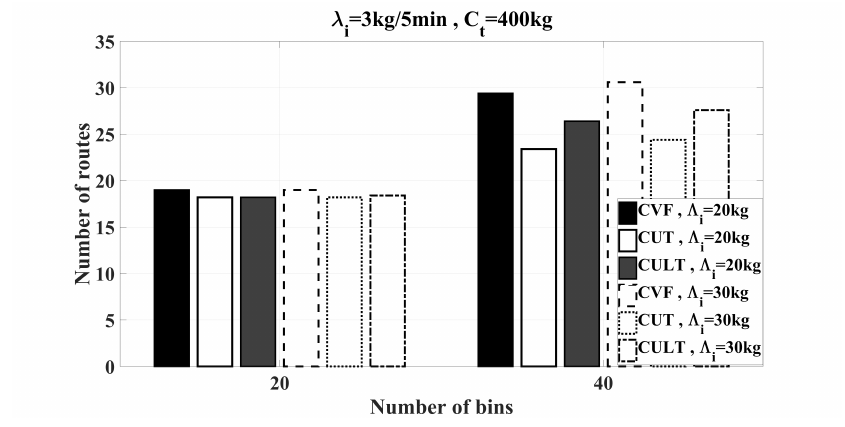
Figure 16. Number of routes: bin count when the bin capacity was